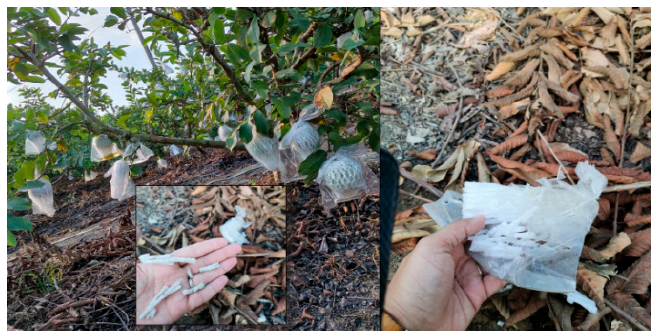
Figure 4. Fruit packing EPE foam net and plastic cover used for the package for the fruits in farm